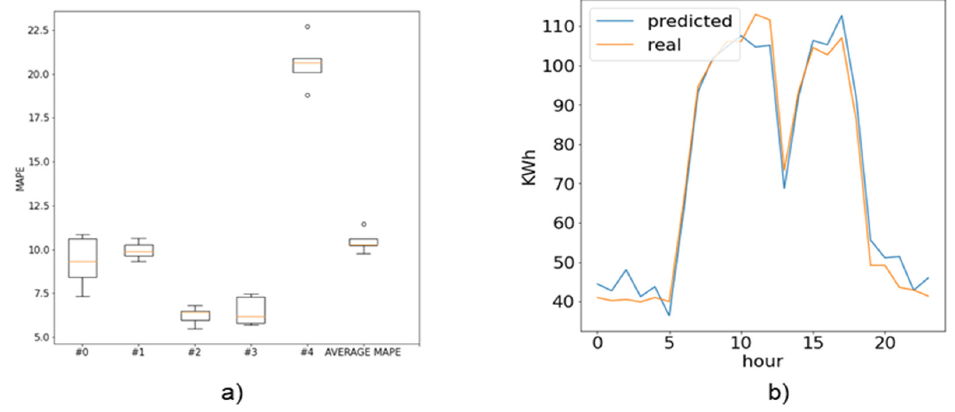
Figure 9. ( a ) Edge learning MAPE ( b ) Energy prediction for a Prosumer #3. In the blockchain-based distributed FL case, we tested two configurations: one with IID data, and one without IID data. For the IID configuration, the energy data were distributed randomly among edge prosumer nodes which facilitates the convergence of learning process (see Figure 10). To find the number of iterations for the learning model, the validation and train loss were compared during a long training session. In this case, the local energy data at the edge contained samples from every prosumer part of the test case. The accuracy of the prediction process is better but did not exceed the accuracy of the centralized approach. Nevertheless, such data distribution improves the convergence of the distributed FL prediction